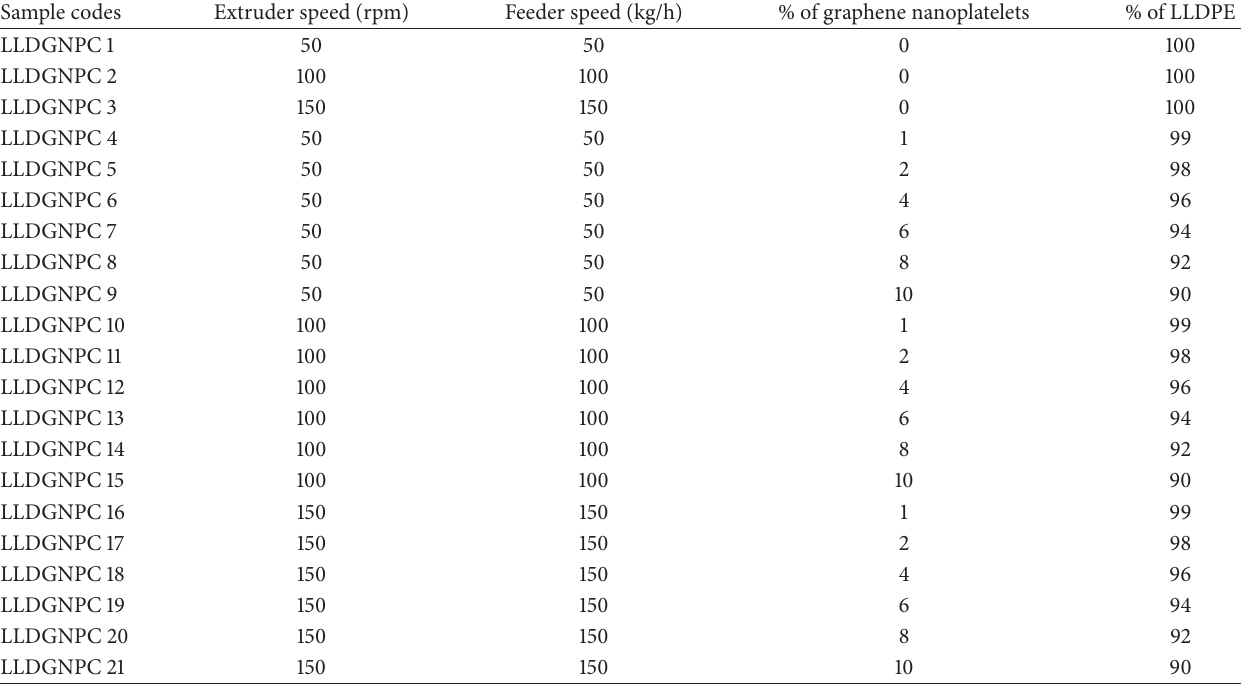
Table 1: List of extruded samples